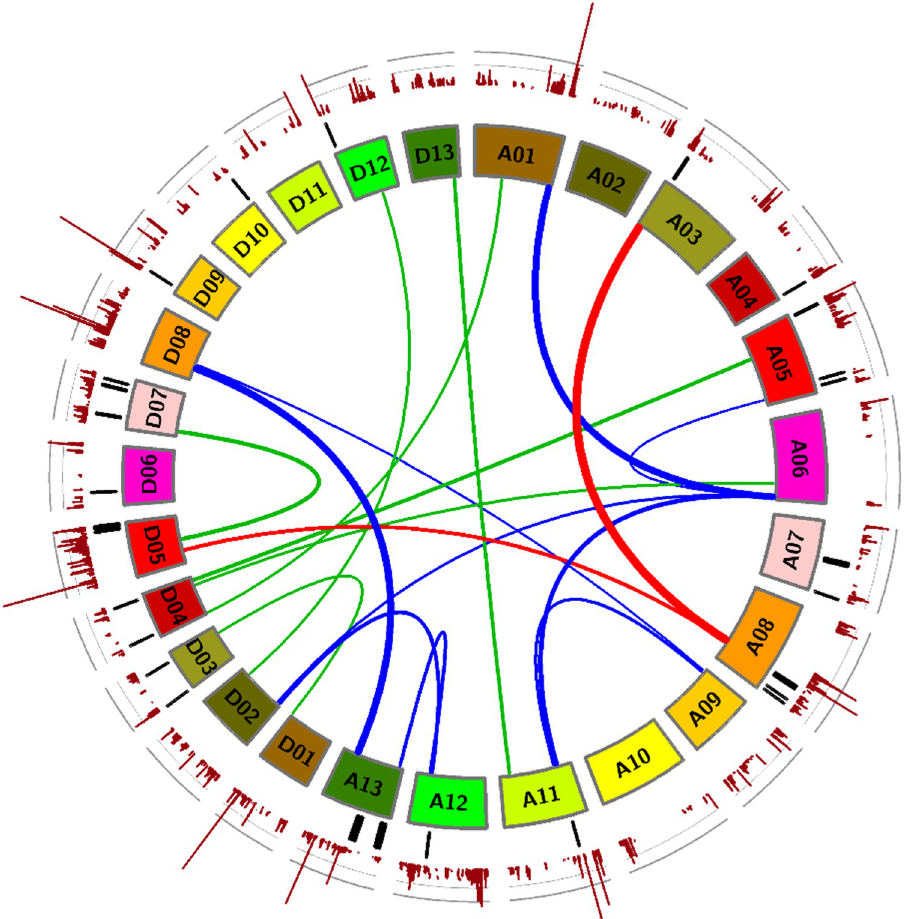
Fig 4. GWAS loci, epistatic interactions and genetically linked loci influence flammability of cotton fibers. The thickness of the innermost links between chromosomes reflect p-values of the 242 most highly significant (-logP > 9) epistatic interactions detected by PLINK, using 473,517 SNPs and HRC data from 257 RILs. The colors of these links facilitate identification of potential multi-gene networks. The outer-most plot represents mrMLM GWAS results. Black lines in between indicate the 405 SNPs that are shared by the RILs that made self-extinguishing fabrics and are absent from the RILs that did not. See also S2–S4 Tables.